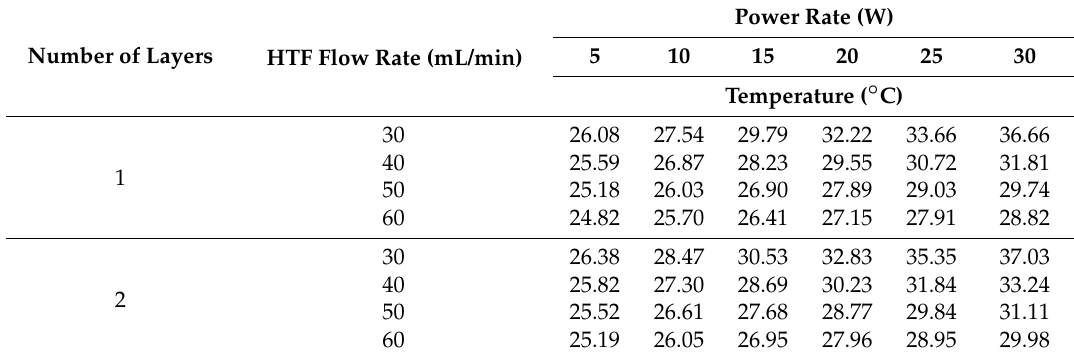
Table 9. The HTF outlet temperature for various HTF flow rates and power rates for the different layers MLM heat